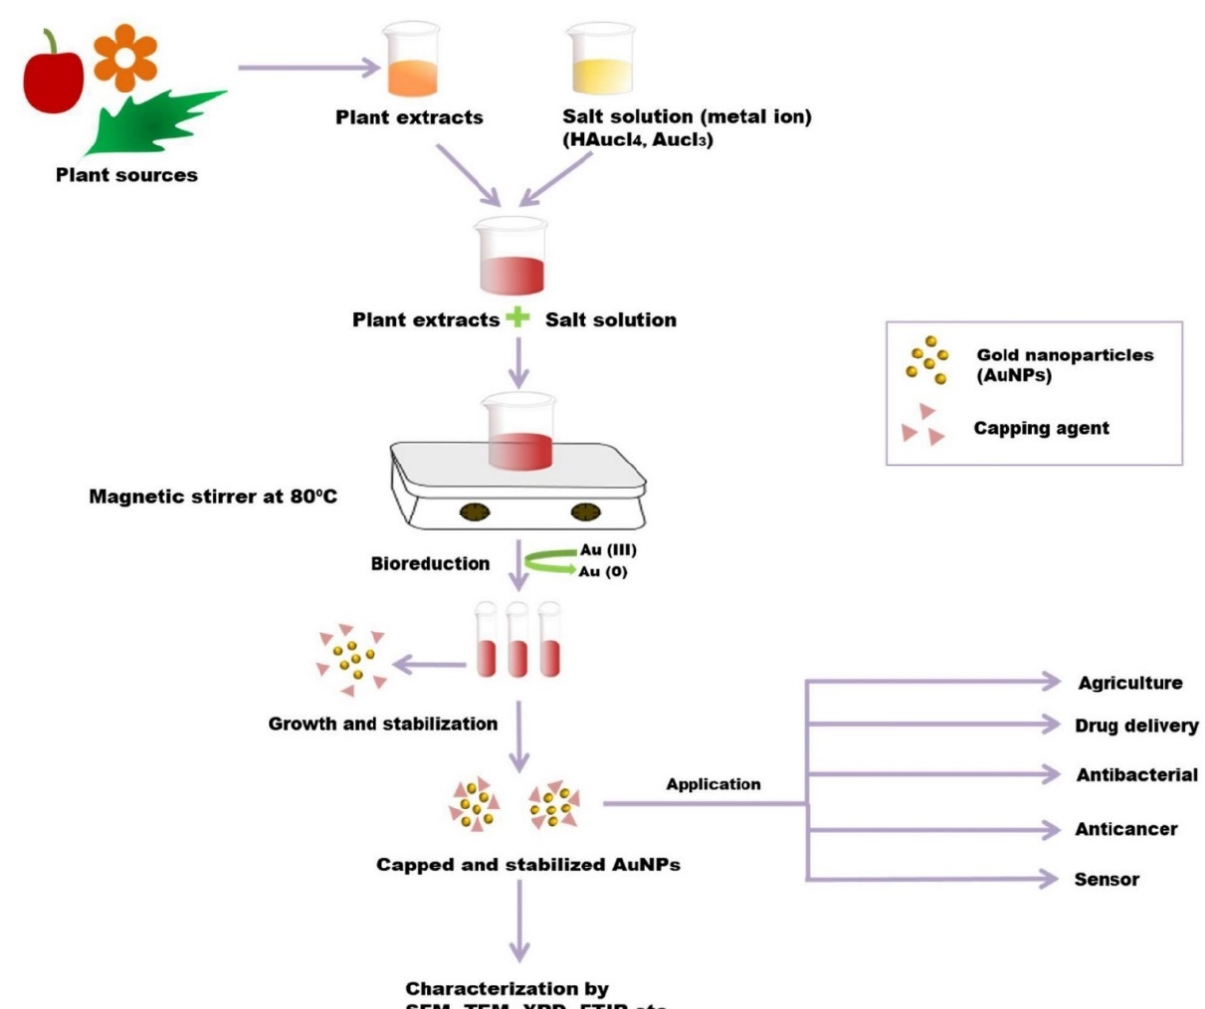
Figure 4. Schematic representation of the green synthesis of AuNPs using a plant. The characterized plant-based AuNPs have a variety of applications in agriculture and medicine (as nanosensors and drug delivery vehicles). Reproduced with permission from [82], MDPI, 2021.